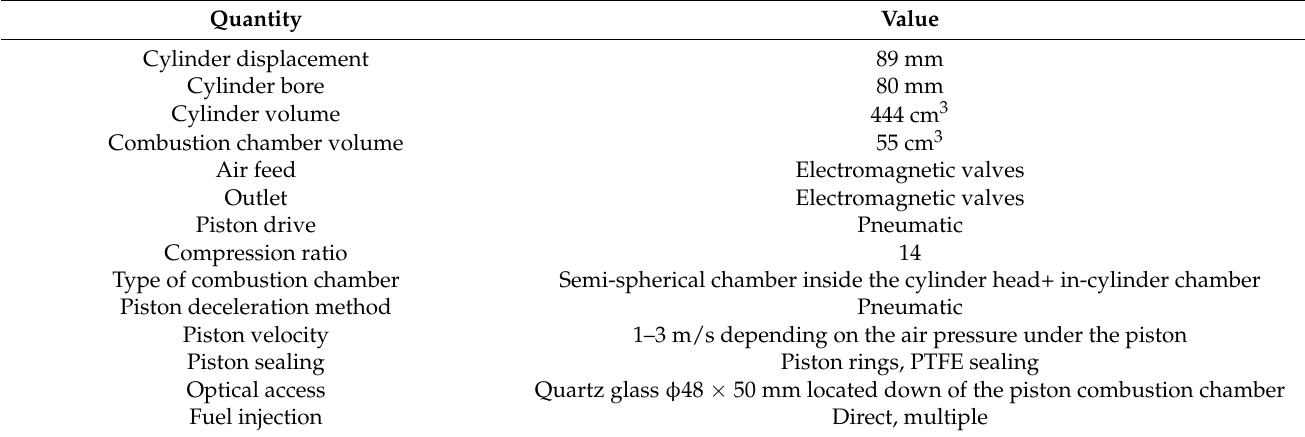
Table 2. Technical specifications of the RCEM.